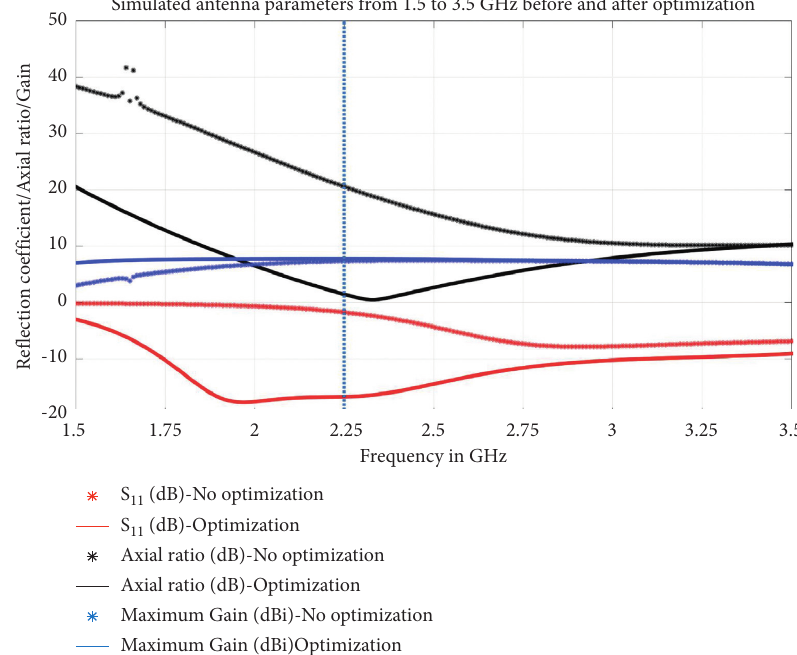
Figure 5: Comparison of simulation antenna parameters before and after optimization.